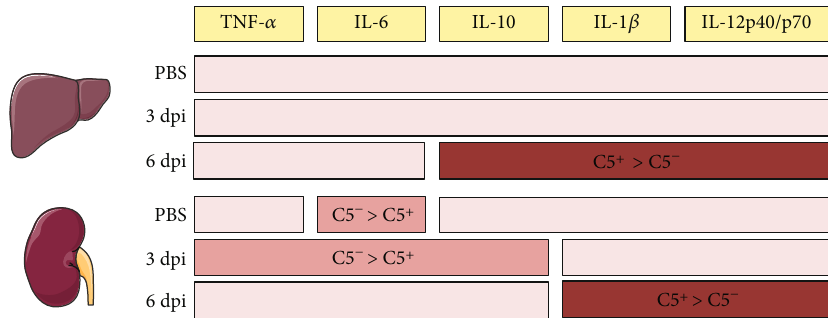
Figure 7: Cytokine levels are dependent on the presence of Complement component C5 during early infection by LPF. Pro- and anti- in fl ammatory cytokines were evaluated in the liver, lung, and kidney. The levels of IL-10, IL-1 β , and IL-12 (p40 and p70) were higher in the liver of A/J C5 +/+ (C5 + ) versus A/J C5 -/- (C5 - ) mice on the sixth day of infection. Although the kidneys are the organs a ff ected in the chronic period of LPF infection, the lack of C5 was important for the production of TNF- α , IL-6, and IL-10 on the third day of infection. However, the presence of C5 promoted the synthesis of IL-1 β and IL-12 (p40 and p70). Since no di ff erence was found in lung cytokine levels regarding the presence or lack of C5, this organ was omitted. dpi: days